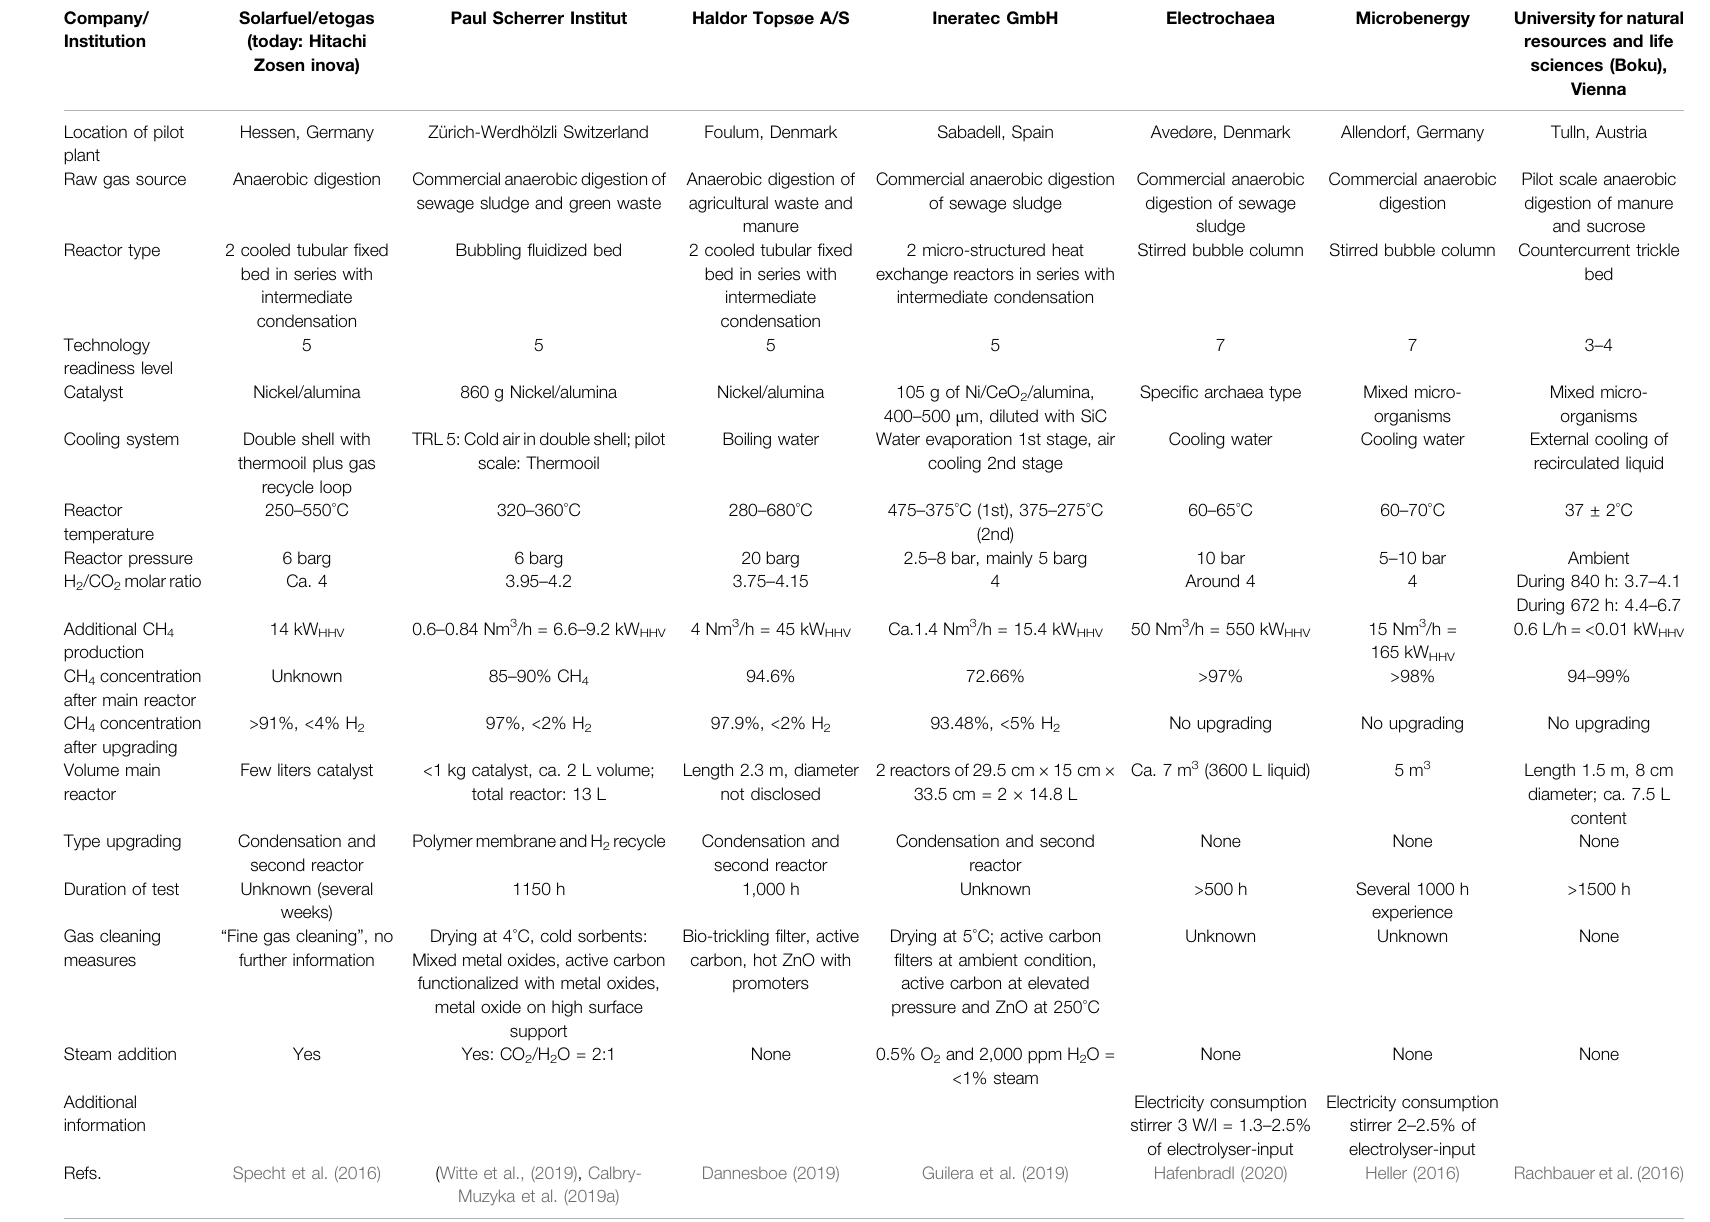
TABLE 1 | Overview long duration testing of direct biogas methanation. Company/